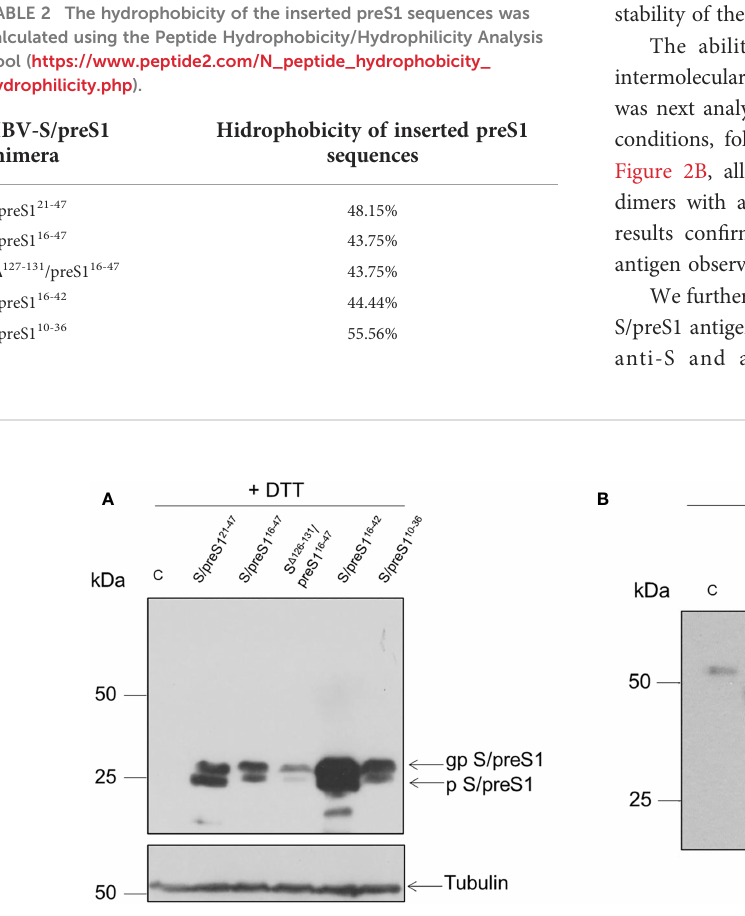
FIGURE 2 Expression of novel HBV S/preS1 antigens in mammalian cells. HEK293T cells were transfected with pCi plasmids encoding the indicated antigens or the empty pCi plasmid as control (C). (A) Cell lysates were analyzed by western blot under reducing (+DTT) conditions. (B) Cell lysates were analyzed by western blot under non-reducing (-DTT) conditions. Glycosylated (gp) or non-glycosylated (p) S/preS1 proteins were detected with anti-preS1 antibodies. Tubulin was used as a loading control. Representative images are shown